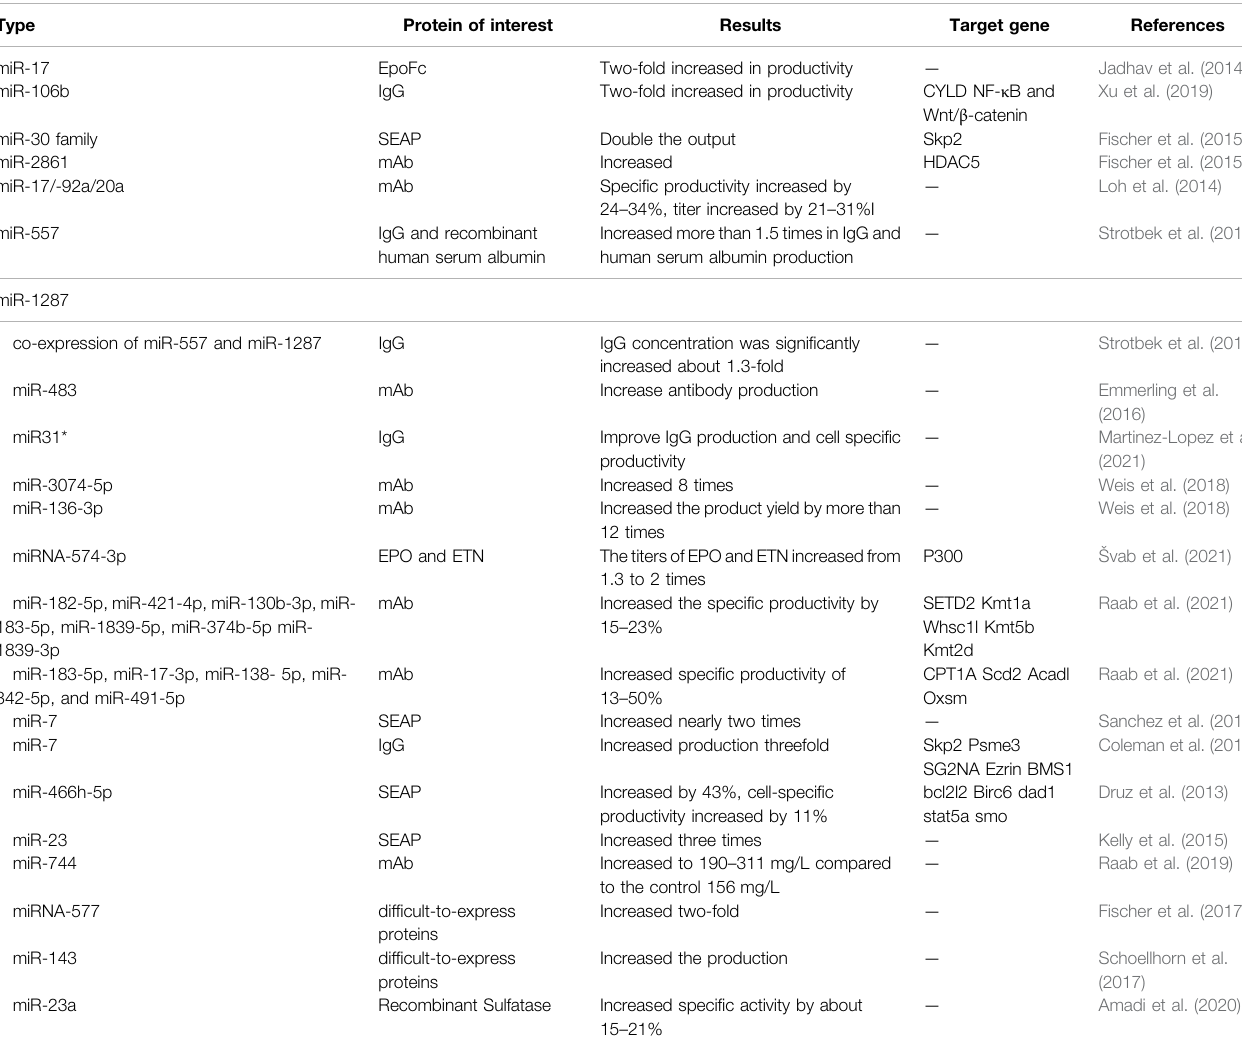
TABLE 1 | The effect of miRNAs on expression of recombinant protein in CHO